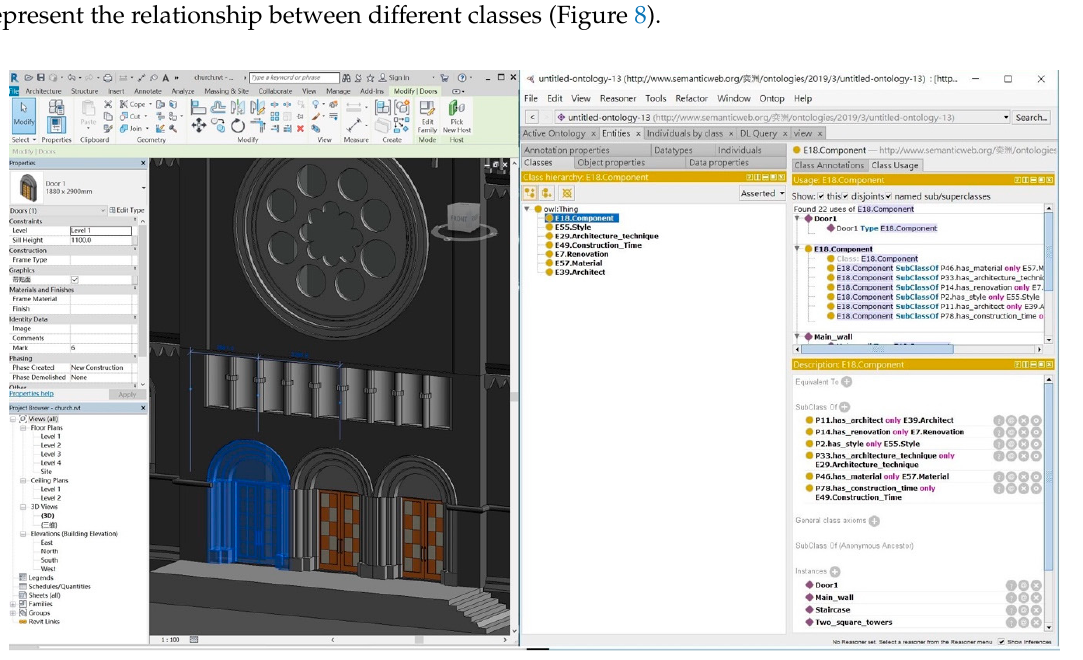
Figure 7. Ontological knowledge modeling for the HBIM entities within the standards of CIDOC CRM.